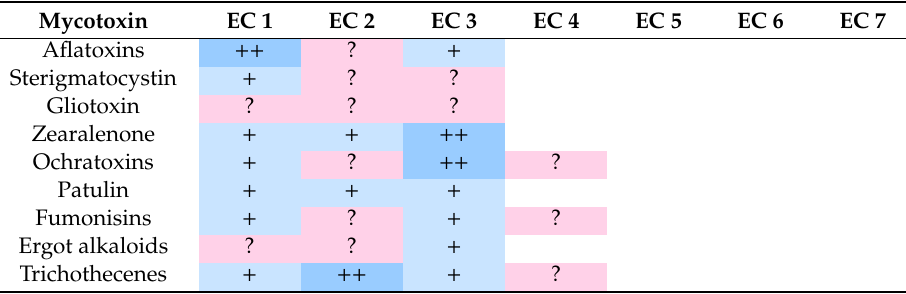
Table 2. Summary of enzyme classes (EC) interesting for use in detoxification of mycotoxins. Potent enzyme classes currently being unknown to modify mycotoxins are marked with query sign (magenta background). Few or multiple enzymes known to posses such activity are designated by single or double plus (cyan background),